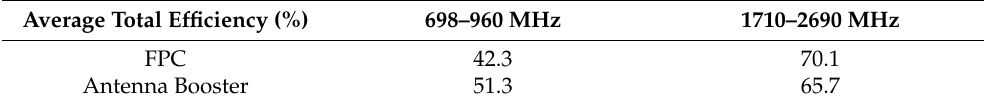
Table 1. Measured total efficiency for the FPC off-PCB and an antenna